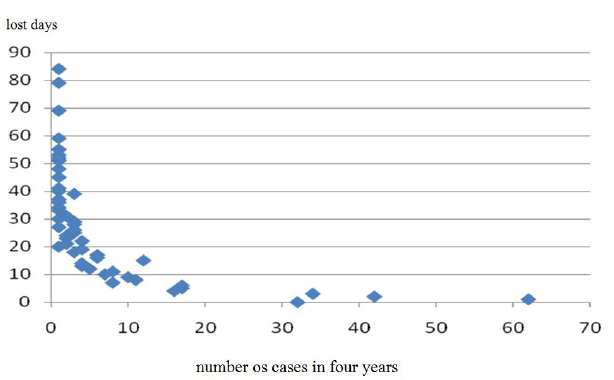
Fig.1. Distribution of lost days in relation to number of cases in the four study years.